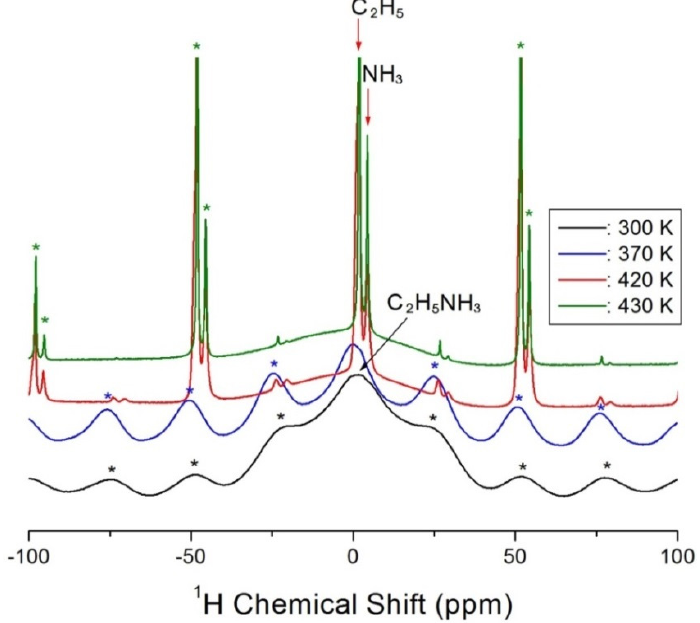
Figure 3. 1 H magic angle spinning ( 1 H MAS) NMR spectra of (C 2 H 5 NH 3 ) 2 CoCl 4 at 300 K, 370 K, 420 K, and 430 K. The spinning sidebands for central peak are marked with asterisk.